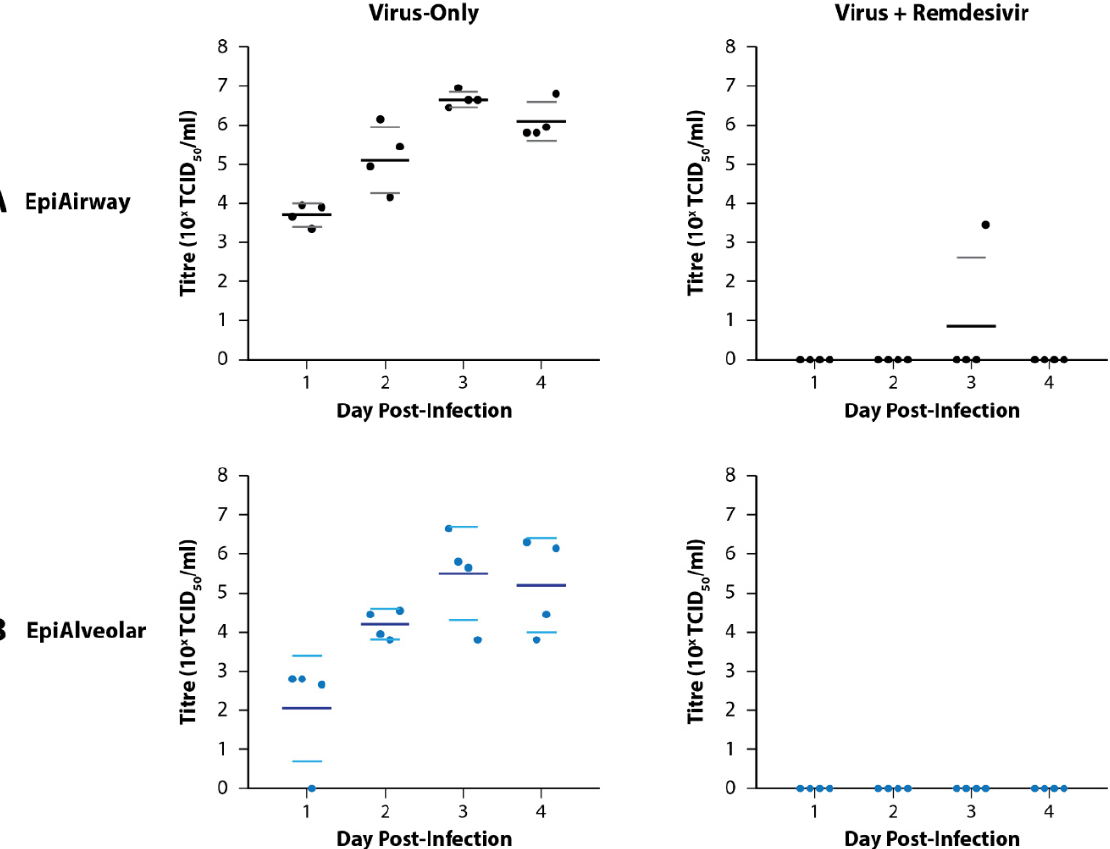
Figure 2. Growth of SARS-CoV-2 Delta in MatTek EpiAirway and EpiAlveolar 3D Tissue Models. ( A ) Growth in the EpiAirway tissue model peaked on Day 3 post-infection with relative reproducibility. An amount of 5 mM remdesivir was effective at preventing detectable infection in all but one of the replicates on Day 3. ( B ) Growth in the EpiAlveolar tissue model also peaked on Day 3 post-infection, but with more variability between the replicates than EpiAirway. A total of 5 μ M remdesivir was effective at preventing detectable infection in all the samples. Dots represent titres from biological quadruplicate samples coloured by tissue type. For horizontal lines, the large dark lines represent the mean titre of the replicates, while the smaller, lighter lines represent the standard error of the mean (SEM).